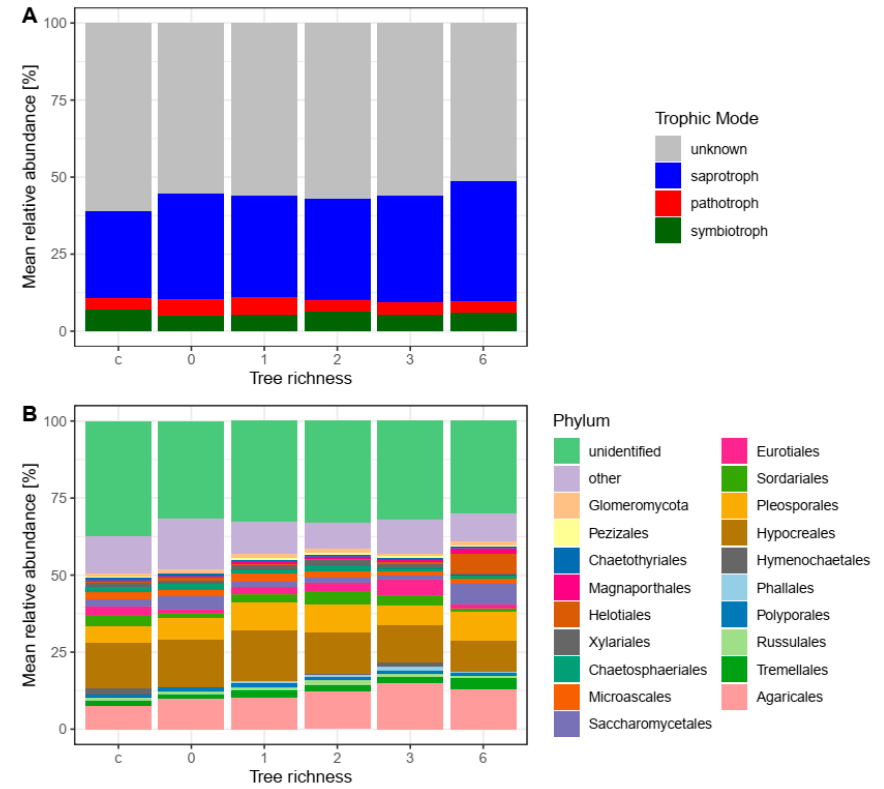
Figure 2. Mean relative abundance of fungal orders ( A ) and trophic groups ( B ) in enrichment plots with 0–6 additional planted tree species and in control plots (c) of oil palm with management as usual.